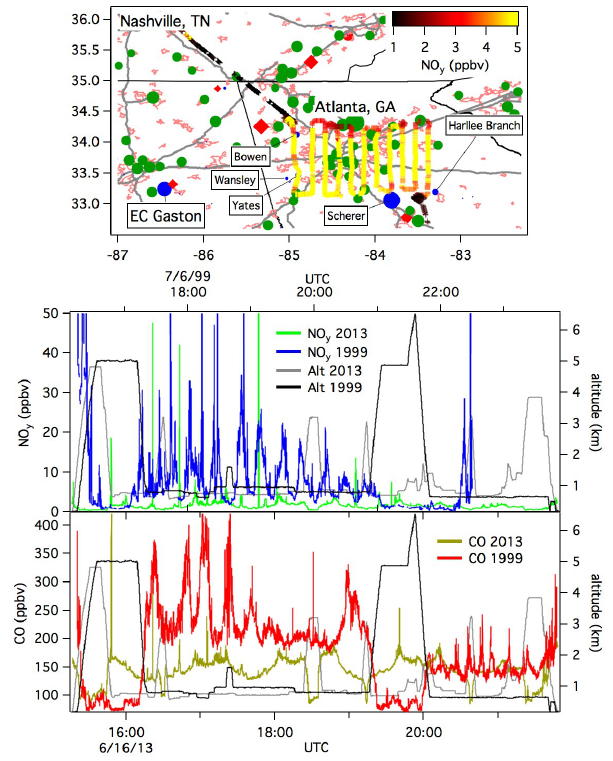
Figure 11. The track of a flight on 6 July 1999 over Atlanta during the SOS99 campaign color-coded with the NO y mixing ratio. Time series of the 16 June 2013 and the 6 July 1999 flights for NO y and CO show that the mixing ratios over Atlanta have decreased signif- icantly over the past 14 years.